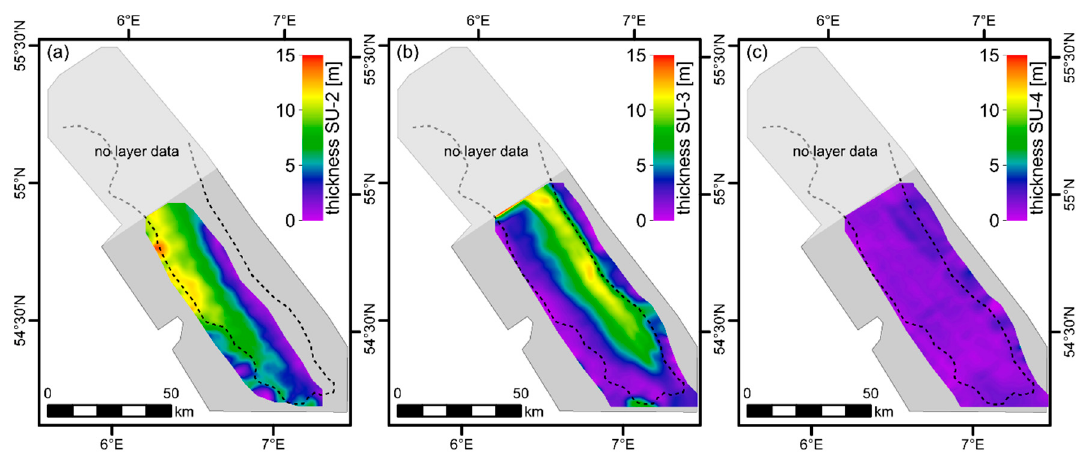
Figure 4. Thickness of the seismic units SU-2 ( a ), SU-3 ( b ), and SU-4 ( c ). Values were not calculated for the northern part of the valley because the density of data was lower and reliable identification of the seismic reflectors was more difficult.